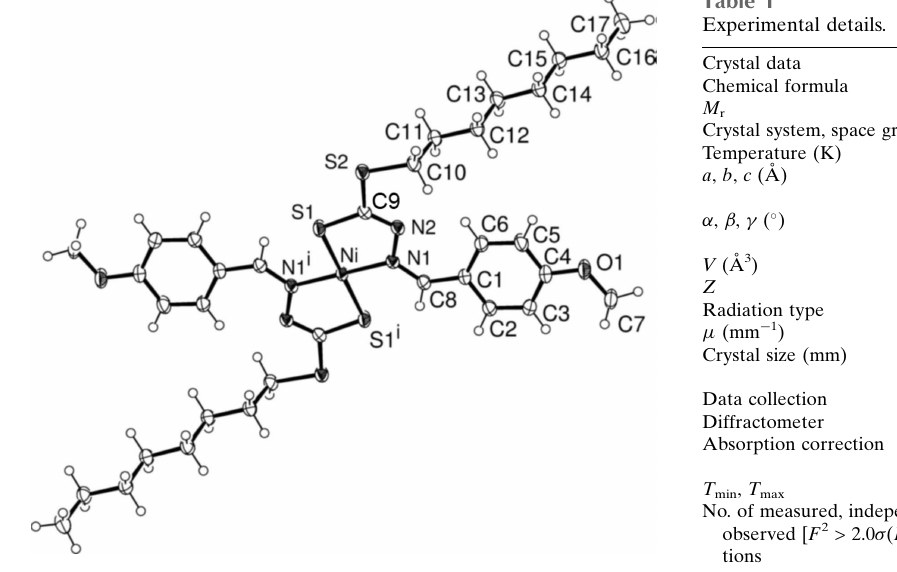
Figure 1 A view of the molecular structure of the title complex, with the atom labelling. Displacement ellipsoids are drawn at the 50% probability level. Symmetry code (i) (cid:5) x + 1, (cid:5) y + 1, (cid:5) z + 1.